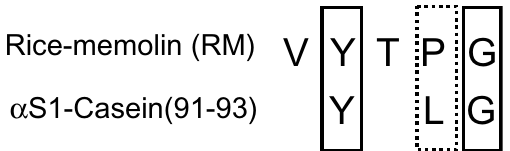
Figure 1. Homology of VYTPG and YLG derived from rice bran and milk casein. Solid lines indicate the same amino acid residues, dotted lines indicate similar